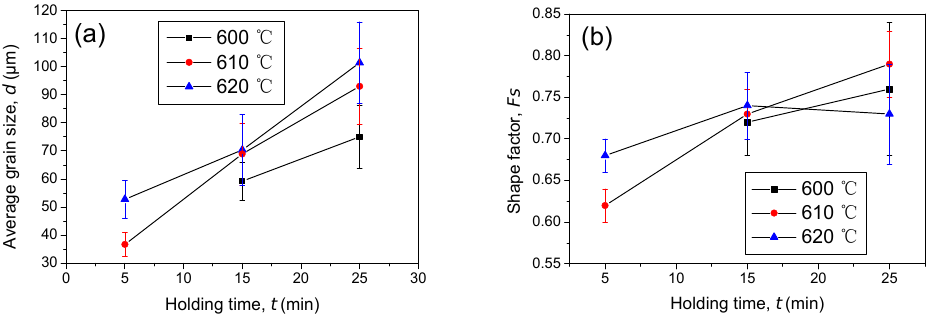
Figure 3. The quantitative results of the average grain size ( a ) and shape factor ( b ) of the RAP-processed AA7075 alloy that soaked at 600–620 °C for 5–25 min.